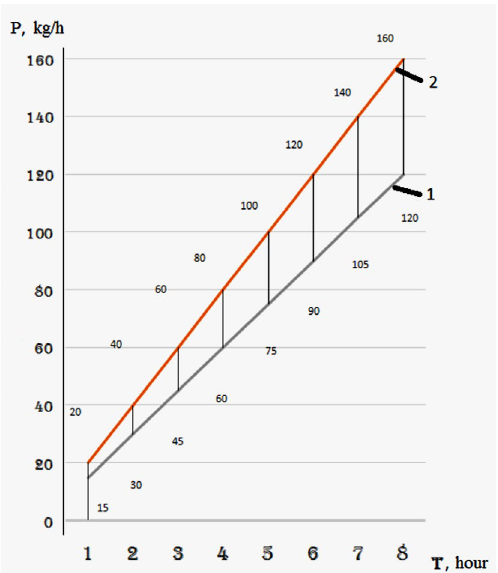
Fig. 7. Dependence of income growth on the volume of generated waste raw